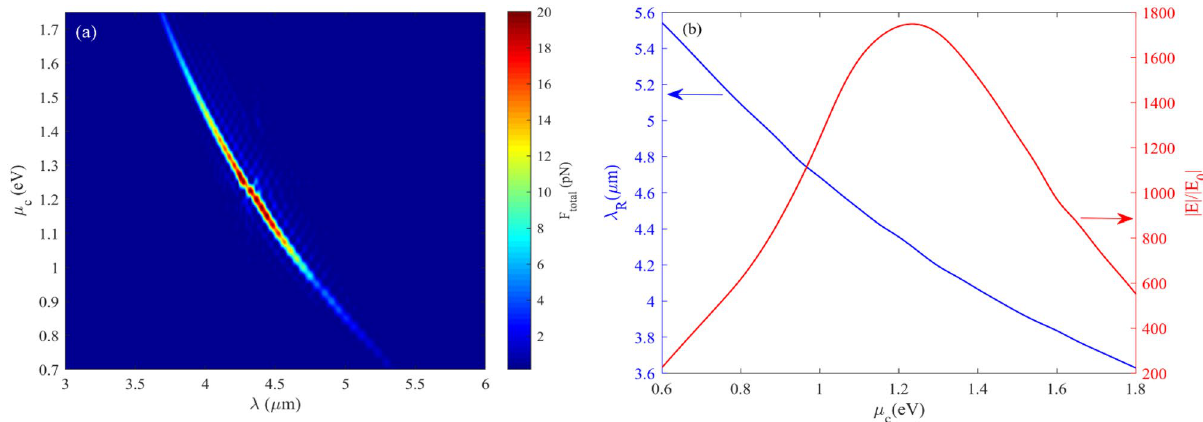
Figure 4. ( a ) The total force felt by a particle with a 20 nm radius as a function of graphene’s chemical potential and wavelength of the incident light ( b ) electric field enhancement and resonance wavelength variation versus graphene’s chemical